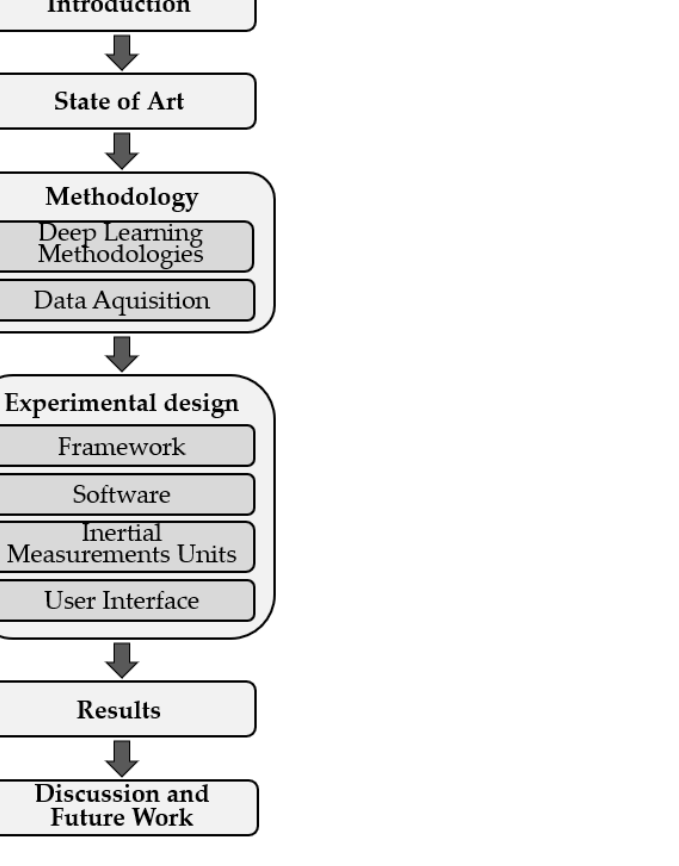
Figure 2. Paper structure flowchart.